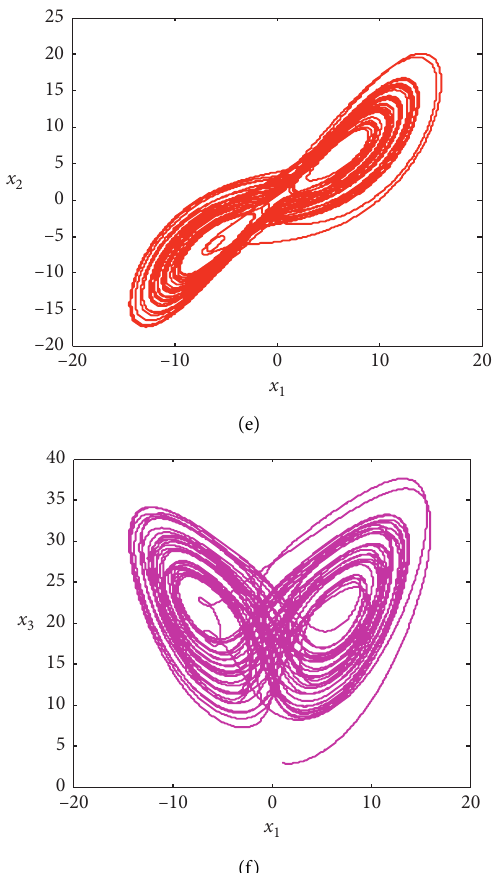
Figure 1: Graphical representation of state variables and the phase portrait (3D) of the Lorenz hyperchaotic